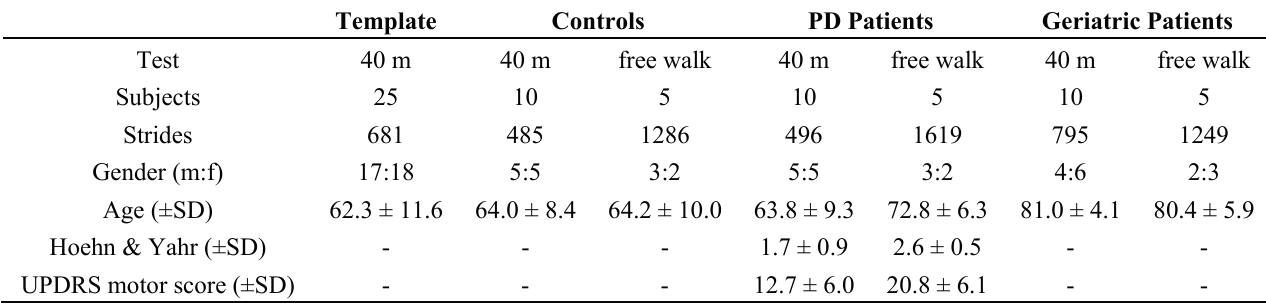
Table 1. Subject characteristics. m: male; f: female; SD: standard deviation; H & Y: Hoehn and Yahr [29]; UPDRS: Unified Parkinson’s Disease Rating Scale